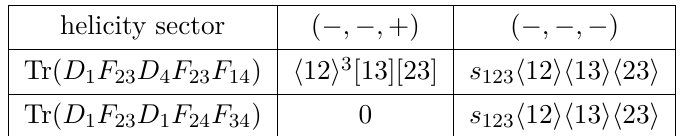
Table 3 . Tree-level minimal form factors of O 00